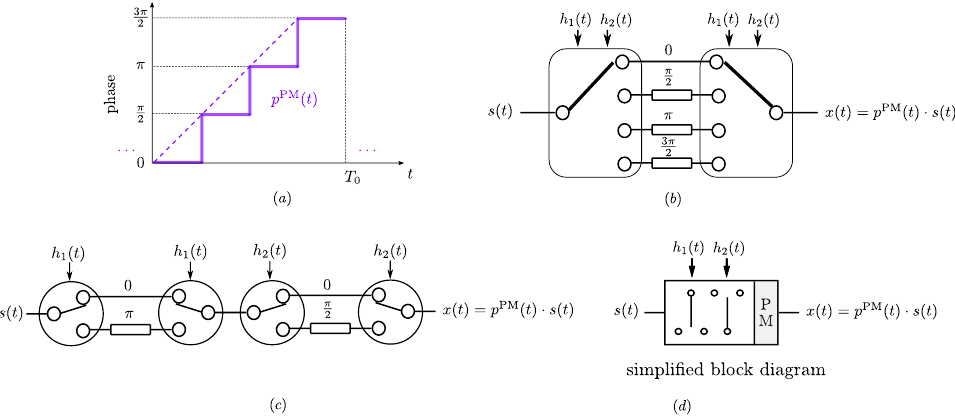
Figure 5. ( a ) 4-level linear phase periodic pulsed waveform p PM ( t ) . ( b ) SP4T architecture capable of time modulating an input signal s(t) with p PM ( t ) . ( c ) SPDT architecture capable of time mod- ulating an input signal s(t) with p PM ( t ) . Note that none of the architectures ( b , c ) require power splitters/combiners. ( d ) Equivalent block diagram.